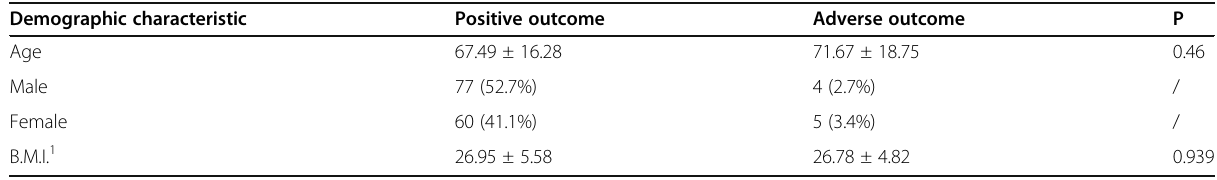
Table 1 Demographic characteristic in the two groups Demographic characteristic Positive